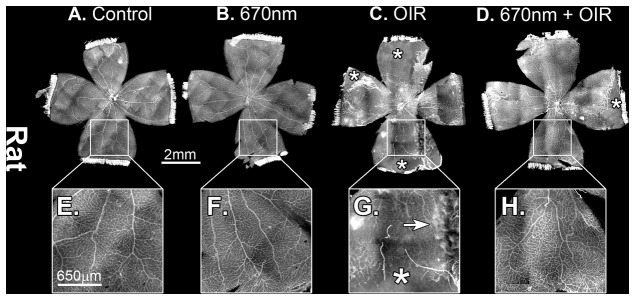
P18 Sprauge-Dawley rat retinal wholemounts, stained with lectin.(A,E) Control and (B,F) 670nm alone mice retina showed no observable difference in peripheral retinal vasculature, while (C,G) OIR alone showed increaed vaso-obliteration (indicated by +) and areas of retinal heamorrhages (indicated by an arrow). (D,H) 670nm+OIR showed amelioration of vaso-obliteration and control like vascular patterning. P – postnatal day, OIR - Oxygen induced retinopathy. Scale A-D = 2mm, E-H = 650µm. Magnification of images E-H are 4x original images.